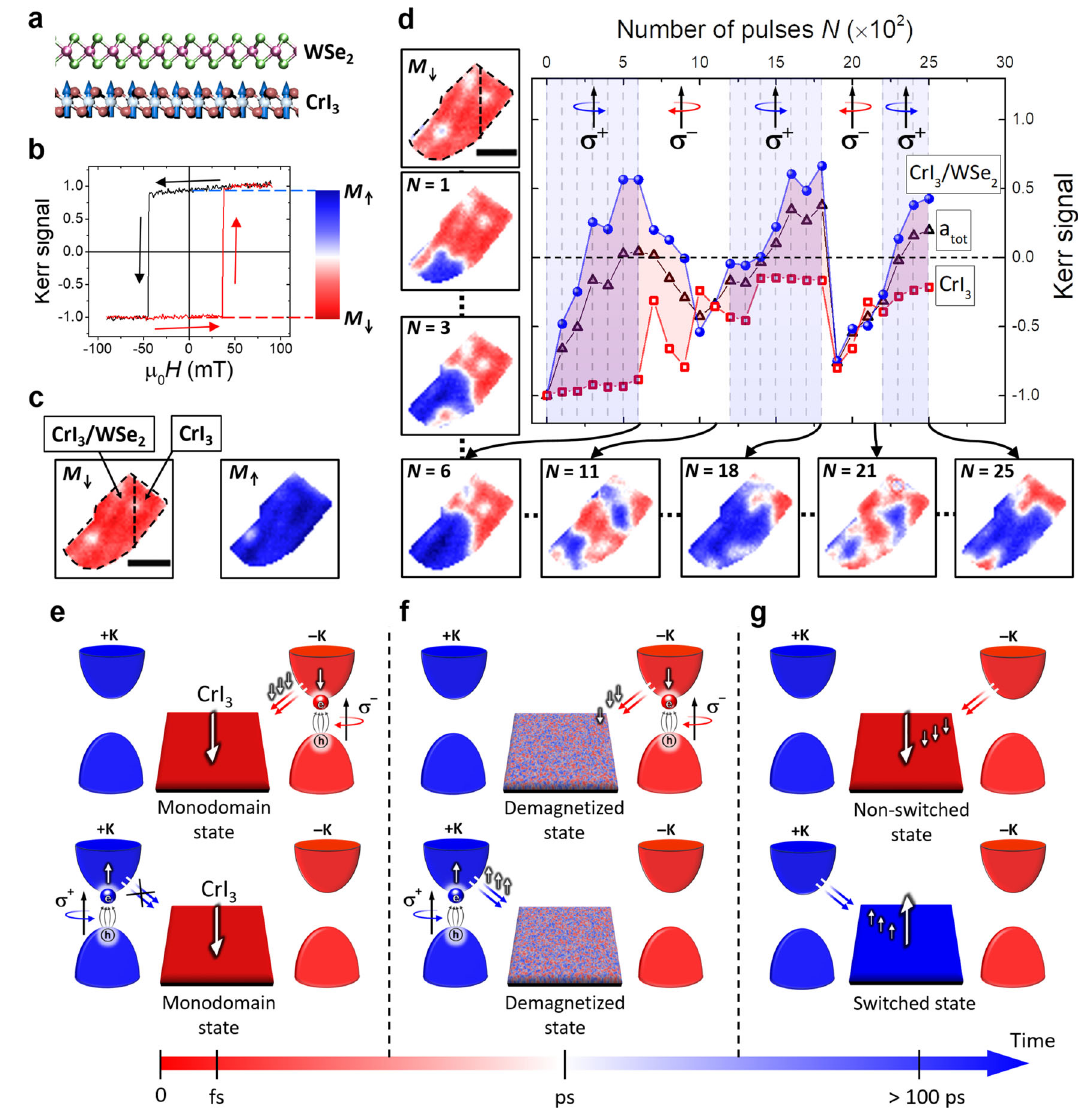
fl ake: total area a tot , CrI 3 /WSe 2 only, and CrI 3 only. The measurements were per- formedat35K,withpumpphotonenergy1.67eV,~30fspulsedurationand fl